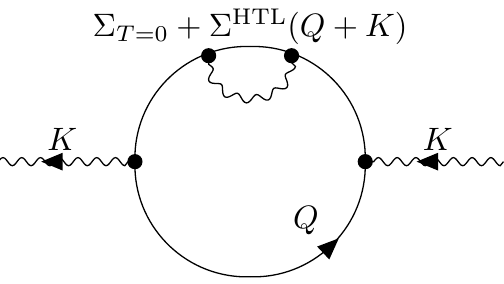
Figure 2. A two-loop contribution to the polarization tensor Π ( 2 ) ( k 0 , k ) .